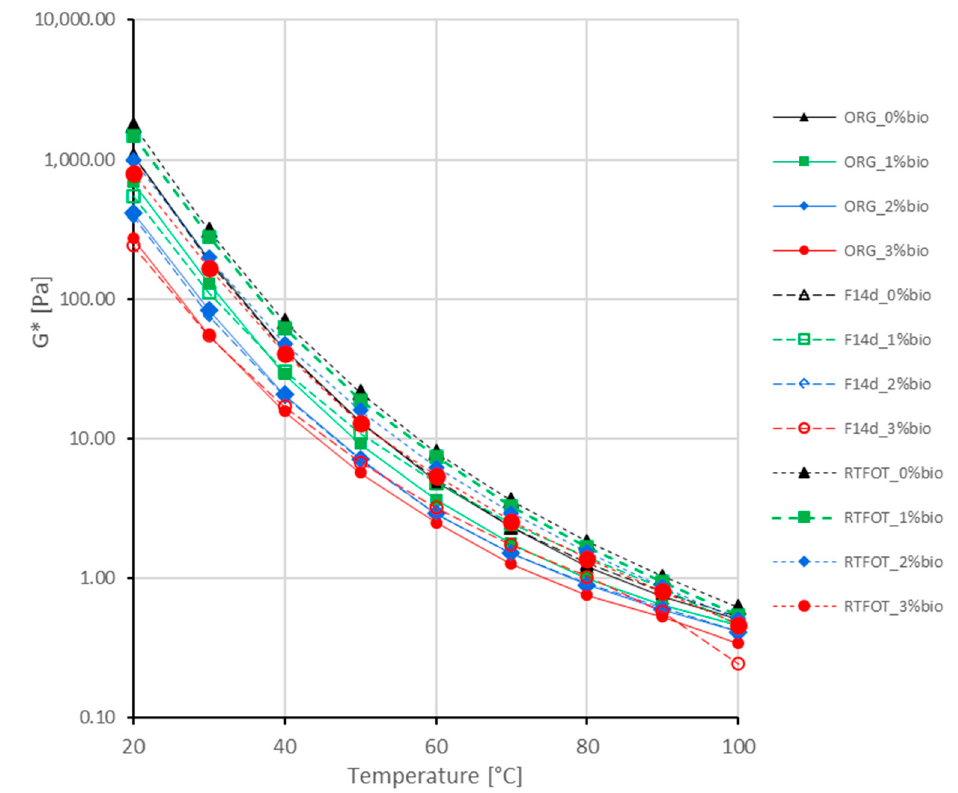
Figure 3. Complex modulus G* results from the 45/80–80 highly modified bitumen. Table 5. Comparison of G* modulus results in 20°C of the 45/80–80 highly modified